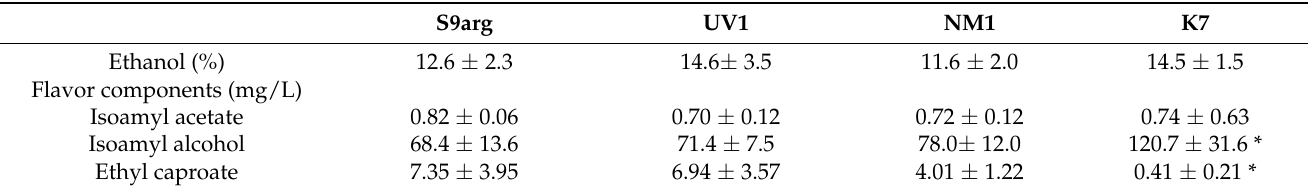
Table 3. Concentration of ethanol and flavor components in the moromi after the laboratory-scale brewing test.